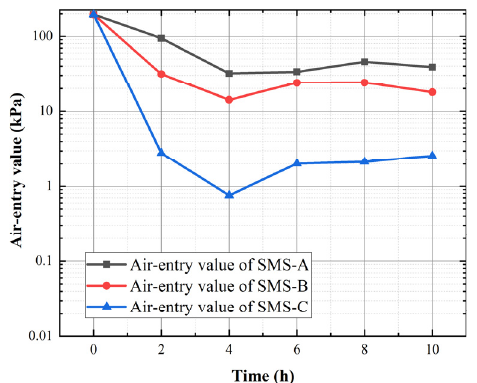
Figure 10. Logarithmic variations of air-entry values of soil after different hydrophobic treatments (the air-entry value at 0 is the air-entry value of plain soil).